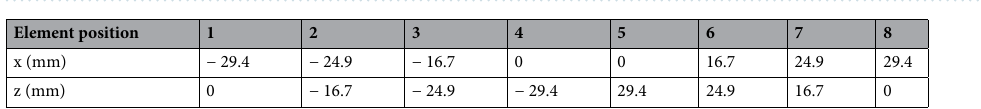
Table 1. Monopole antenna element position relative to the Maxwell fisheye lens centered at x = y = z = 0